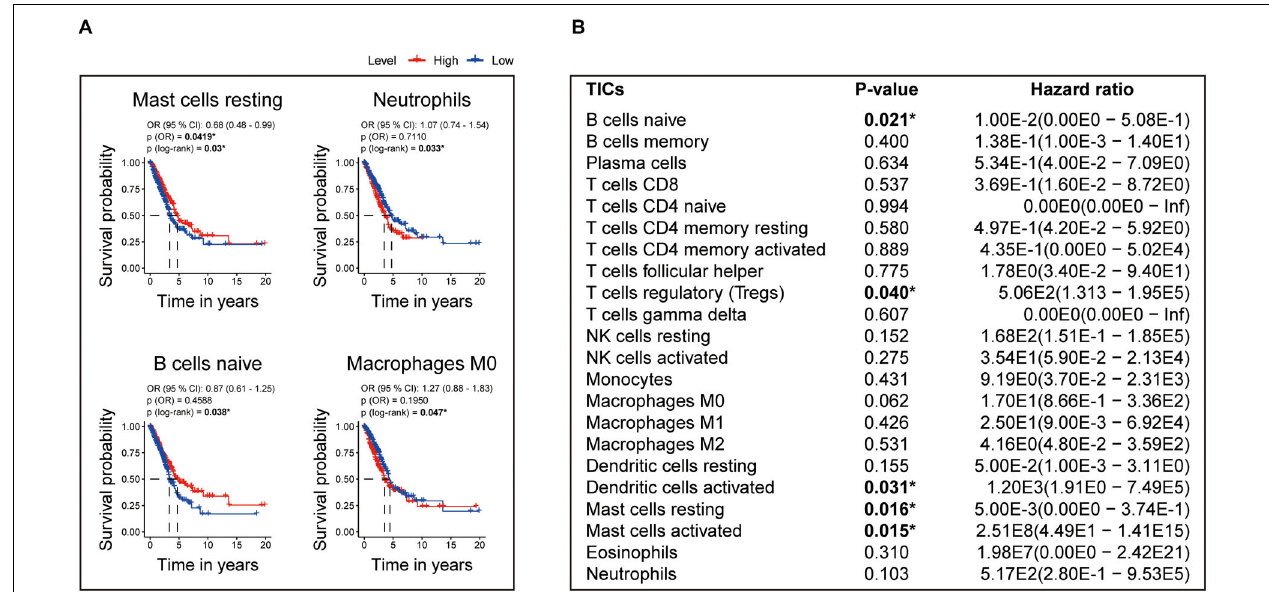
FIGURE 9 | Identification of the prognostic value of each TIC based on the 22 TICs’ infiltration volume and survival data. (A) Kaplan–Meier survival curves. Only curves with p value < 0.05 in the log-rank test were plotted. The odds ratio (OR) and its 95% confidence interval (95% CI) were calculated accordingly. (B) Univariate Cox analysis based on each of the 22 TICs’ infiltration volume and overall survival. All p values were calculated using the Cox regression hazards analysis. * P value is statistically